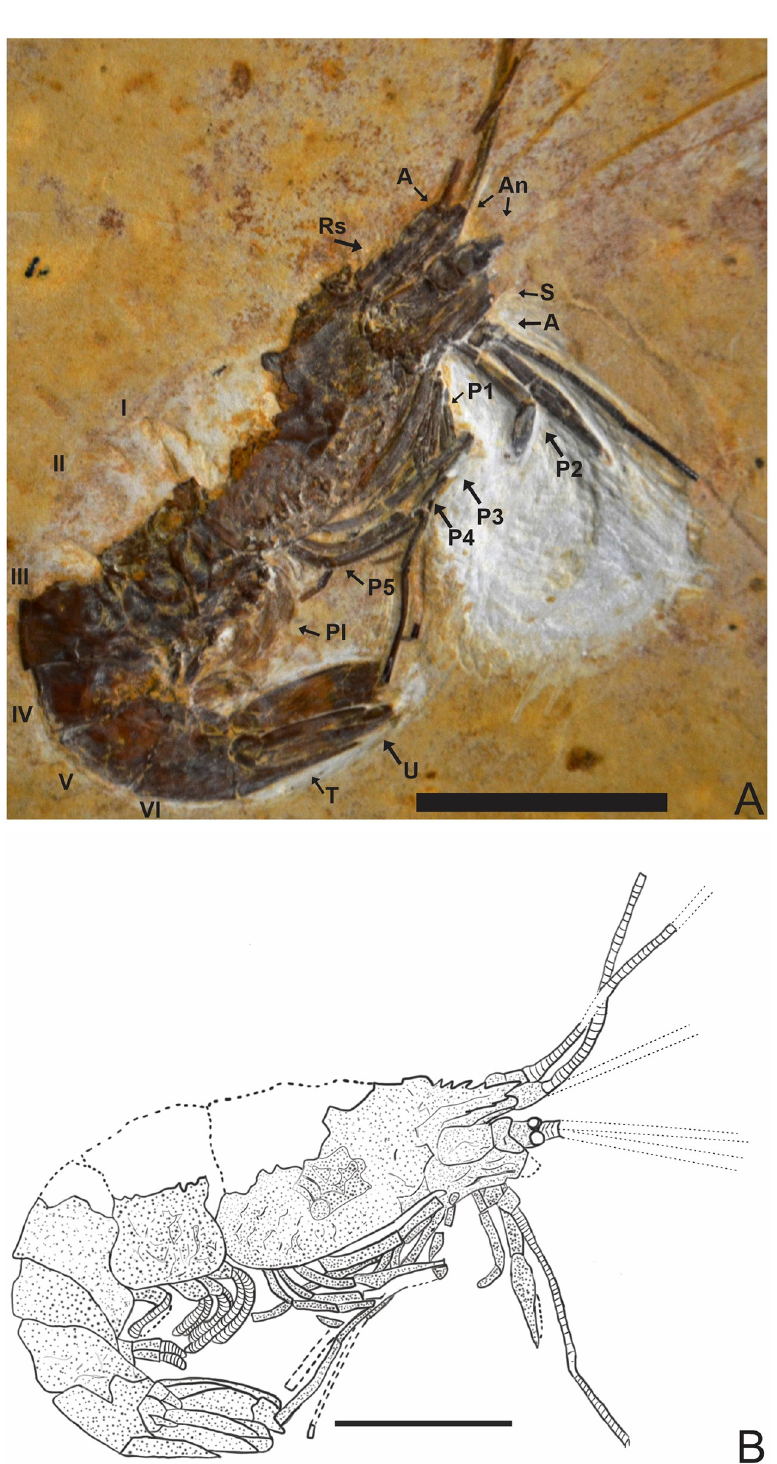
Fig 2. Lateral view of the specimen 2466/CRT (UFC). (A) Detail of the chelae on the second pereiopods. The other P3-P5 pereiopods without chelae with elongate dactylus. Pleopods are visible and are multi-segmented. (B) Reconstitution, dotted lines represent appendages not preserved but with impressions on the matrix. Rs: Rostrum; A: Antenna; An: Antennule; S: Scaphocerite; Pl: Pleopods; P1-P5: Pereiopods; I-VI: Pleon; T: Telson; U: Uropods. Scale bar: 10 mm. Photo and drawing by Olga A.